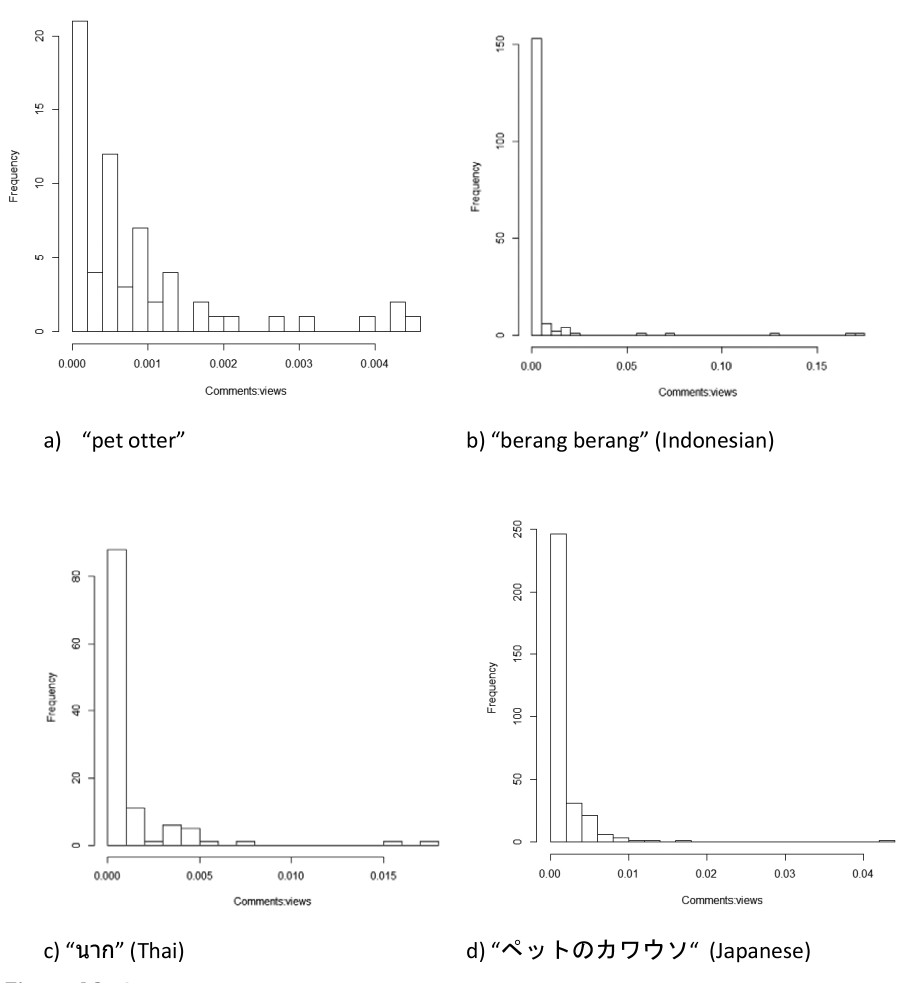
Figure A3. Comment:view